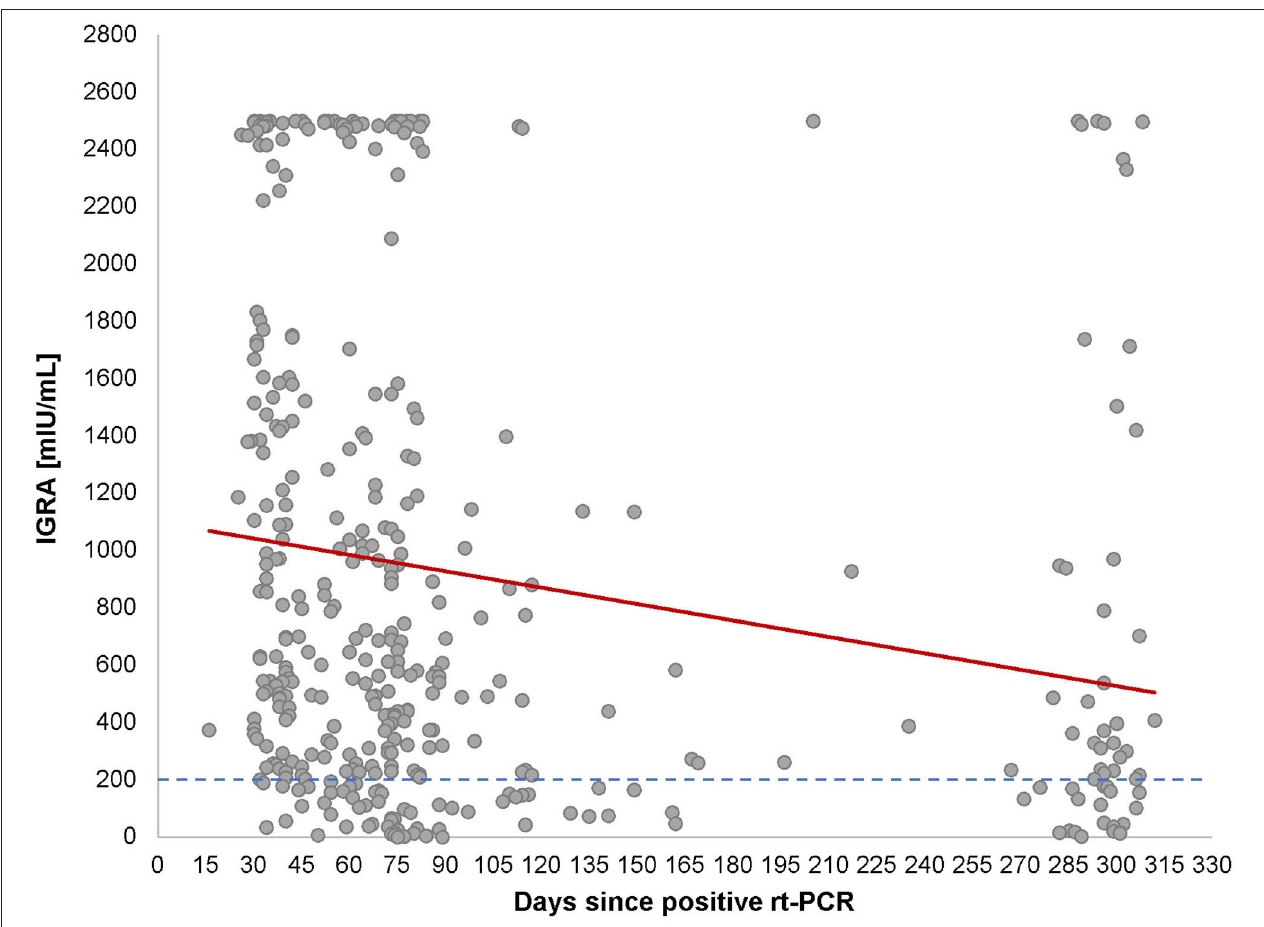
FIGURE 3 | Correlation between Interferon Gamma Release Assay (IGRA) and time after COVID-19 infection. Cross-sectional representation for IGRA values at different time-points for 320 individuals. Each black dot represents one participant and the IGRA milli-international units per milliliter (mIU/ml) and the red line represents the interpretation line, which shows the negative linear association between IGRA values and the days passed since the diagnosis of COVID-19. The dotted line represents the cut-off of IGRA values at 200